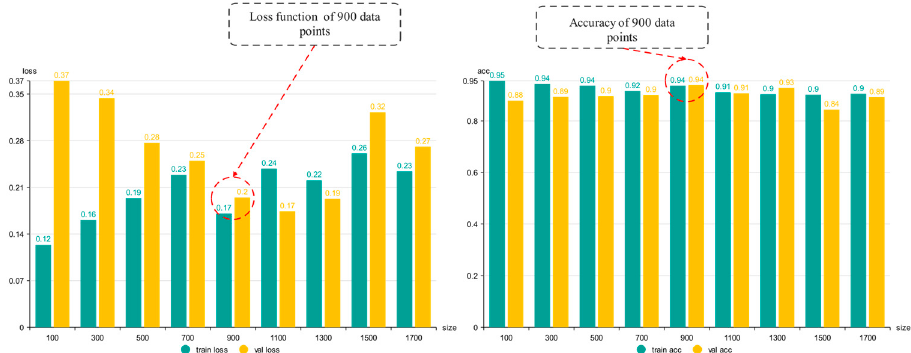
Figure 3. Comparison of loss function and accuracy resulting from training with different signal lengths.